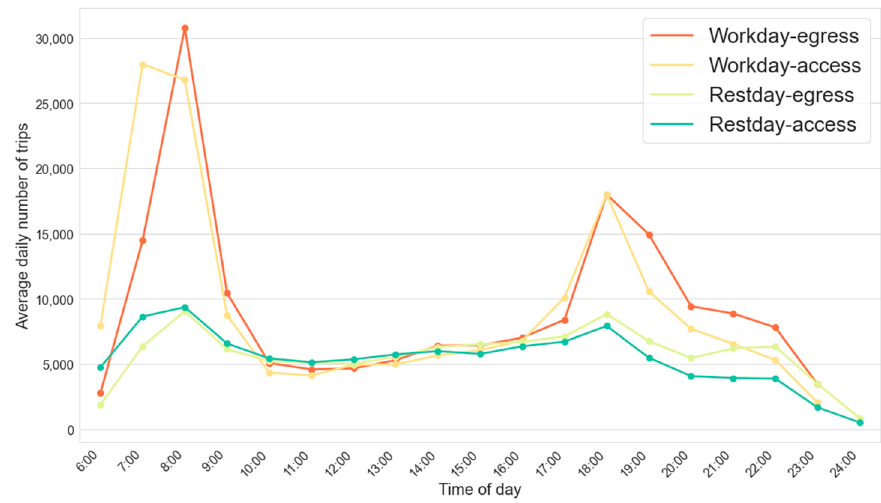
Figure 8. The hourly distribution of daily average ridership for access use and egress use of DBsMIC.